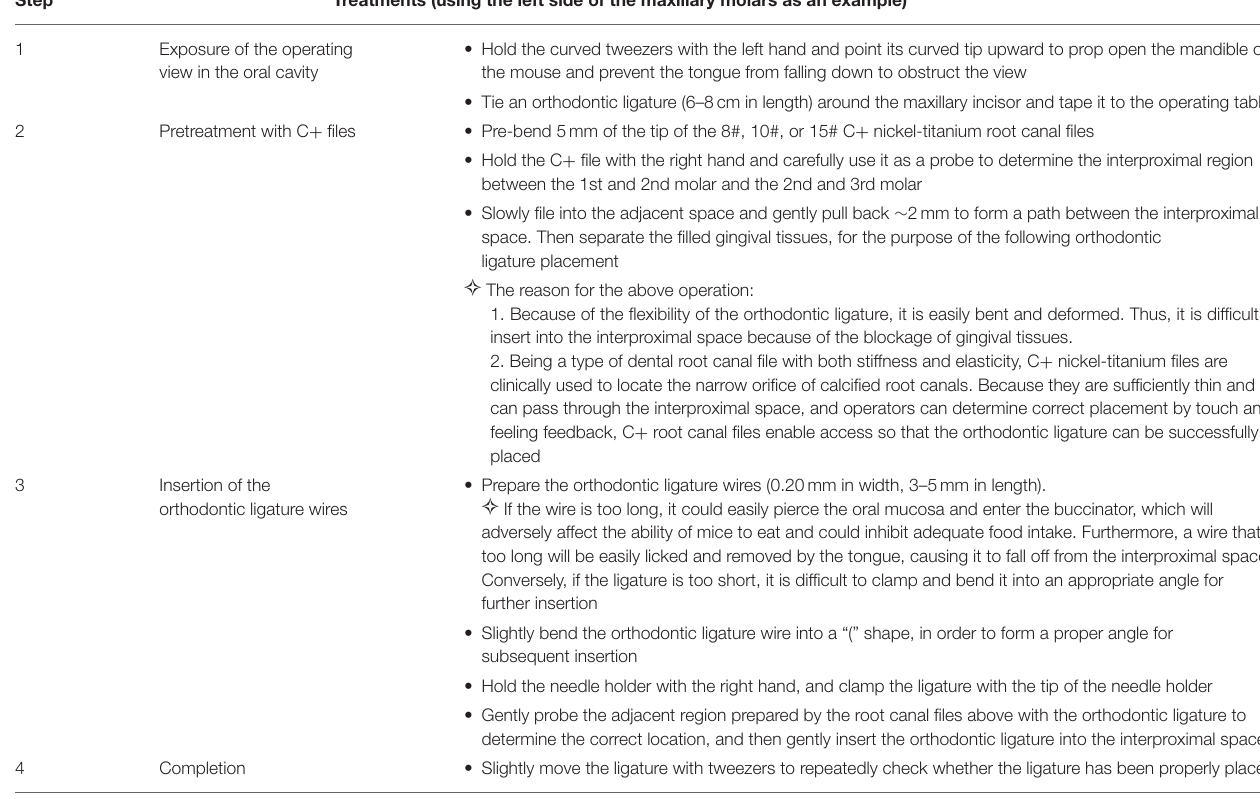
TABLE 1 | Detailed procedure of the modified method to induce experimental